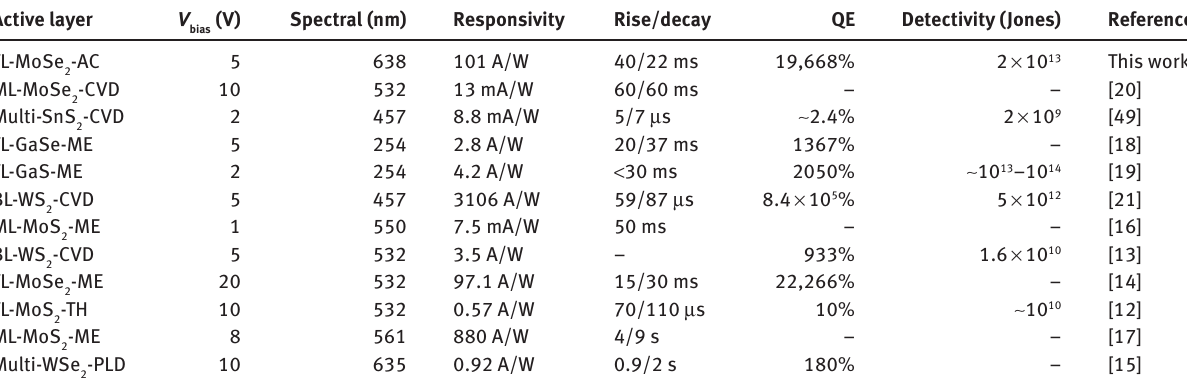
Table 1: Performance comparison of photodetectors based on a layered 2D nanostructure. a